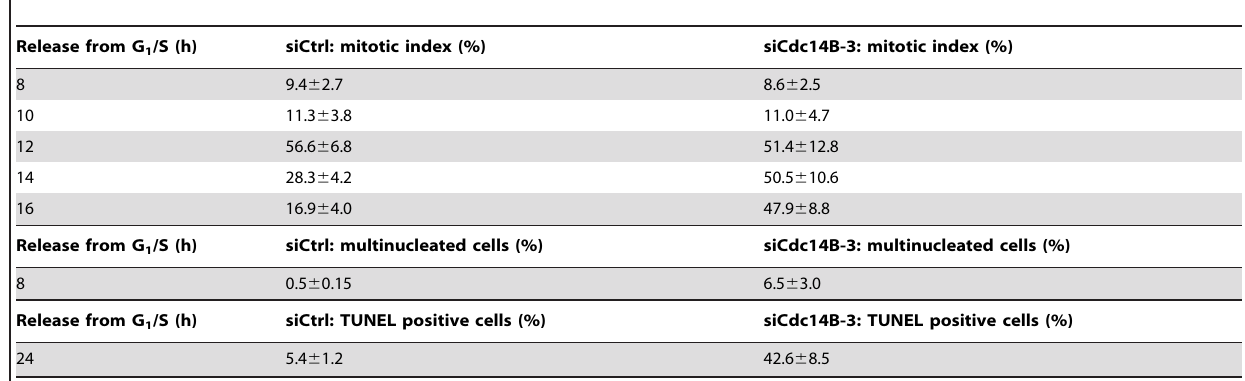
Table 1. Knockdown of hCdc14B leads to increase of the mitotic index, multinucleation and apoptosis.